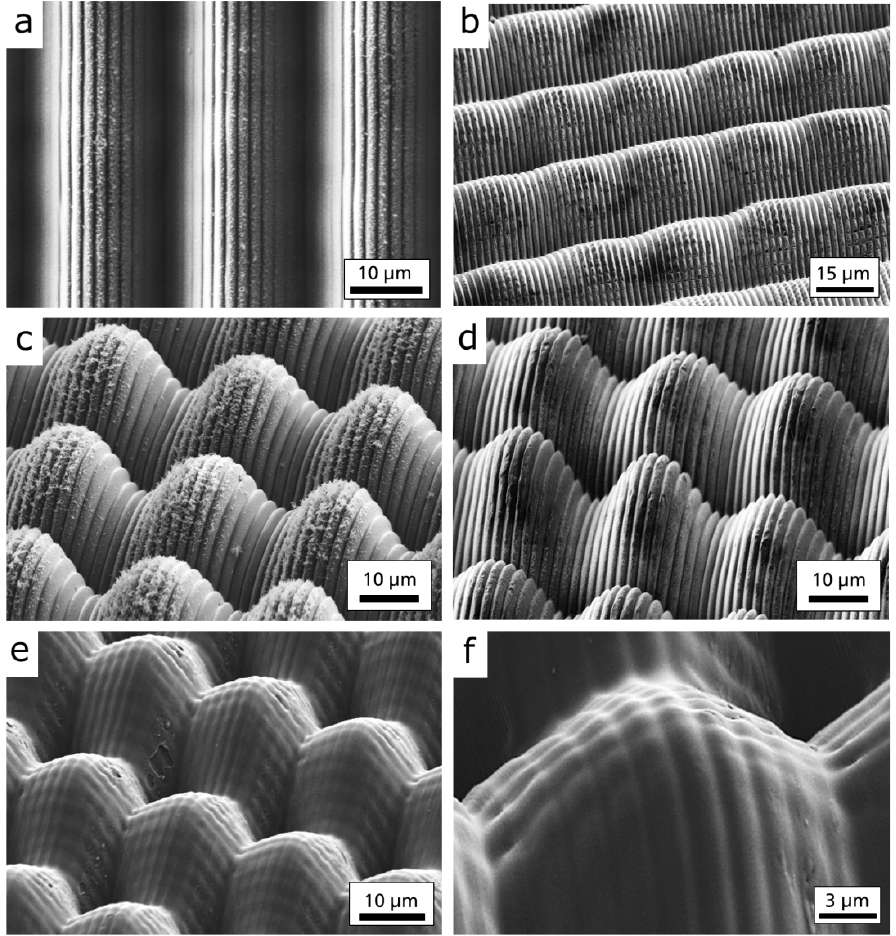
Figure 3. ( a ) Top-view SEM image of the hierarchical line-like on line-like structures parallel oriented, ( b ) line-like on line-like structures perpendicularly oriented, ( c ) line-like structures on pillars before cleaning, ( d ) line-like structures on pillars after cleaning, ( e ) pillar-like on pillar-like structures and ( f ) details of the hierarchy of pillar-like on pillar-like structures [30].